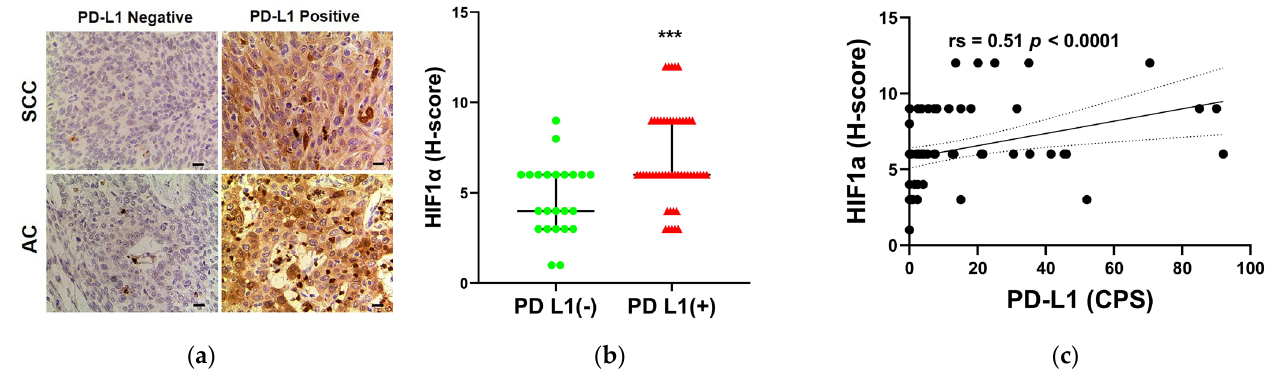
Figure 5. ( a ) Representative imaging of immunohistochemical staining with HIF- 1α expression in PD-L1-negative and PD-L1-positive cervical squamous cell carcinoma tissues (up row) and cervical adenocarcinoma tissues (down row). Scale bar = 50 μm. ( b ) Comparison of HIF- 1α expression with PD-L1 status (*** p < 0.001). ( c ) Spearman correlation analysis of HIF- 1α expression with PD-L1 CPS.